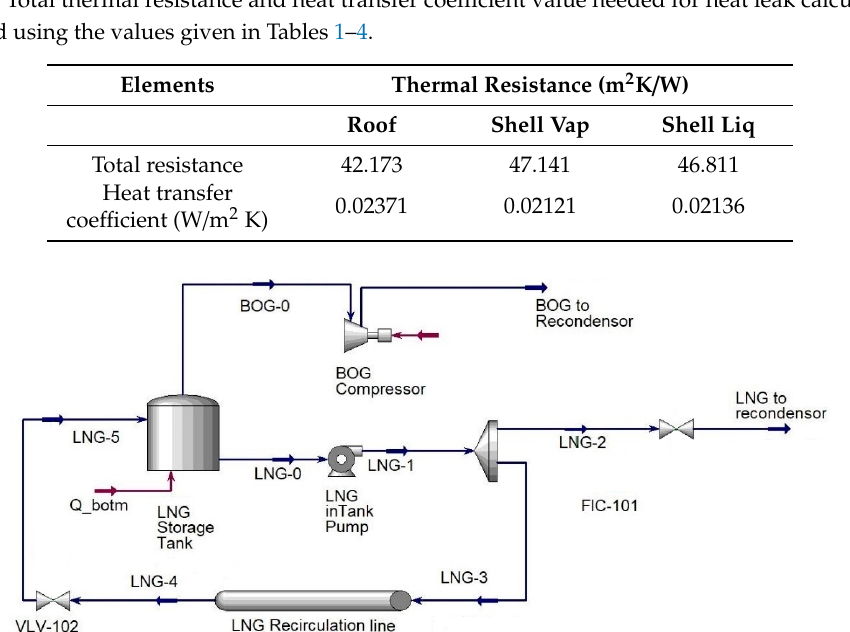
Figure 2. LNG regasification terminal process model considered for Boil-off gas (BOG) estimation.